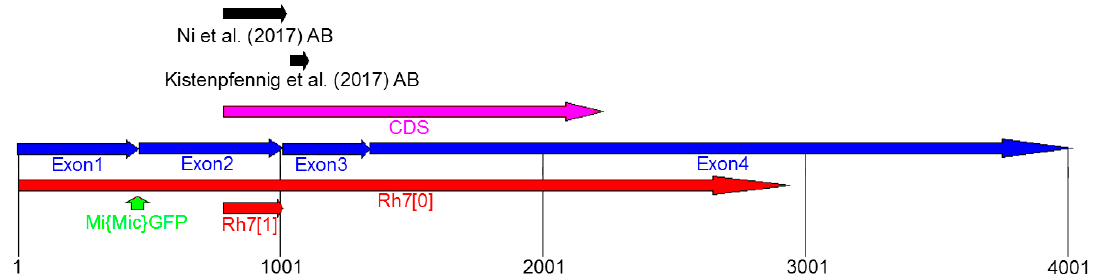
Figure 3. Genomic organization of the Rh7 locus. Rh7 possesses four exons (blue) and the code sequence (CDS) is located between Exon2 and Exon4 (magenta). Both, the Rh7 mutants ( Rh7 0 [19] and Rh7 1 [20]) have different deletions in the Rh7 gene (shown in red). The gfp insertion site of the Mi{Mic} -line is located between Exon1 and Exon2 (green arrow). The antibodies used by Ni et al. (2017) and Kistenpfennig et al. (2017) are raised against the different parts of the Rh7 (indicated by black arrows).